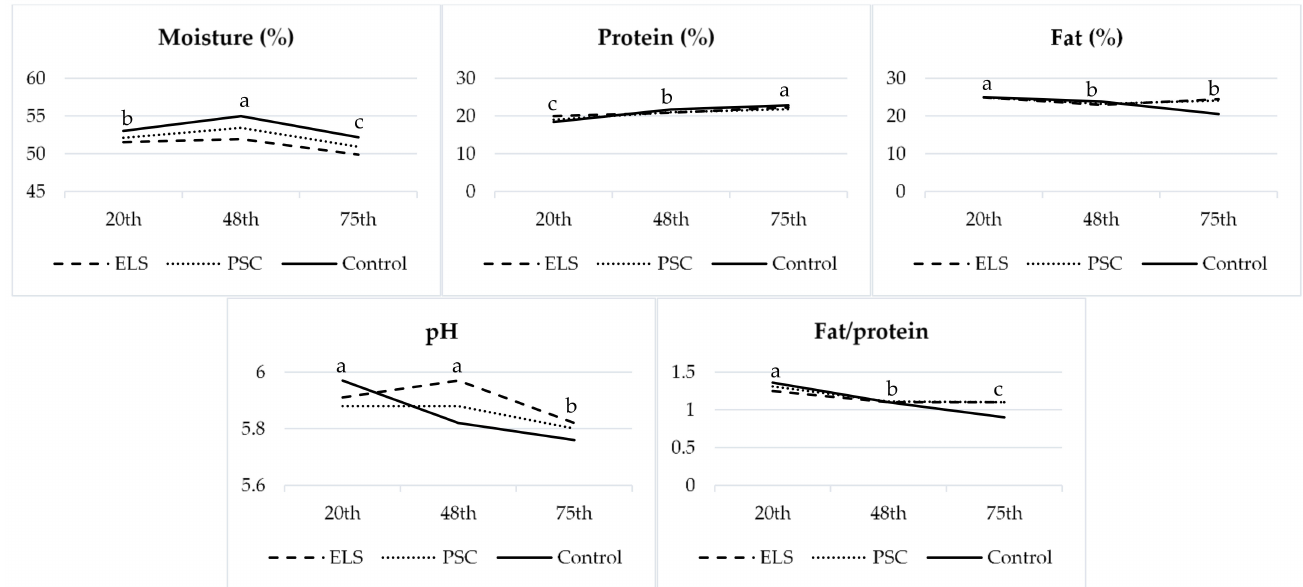
Figure 1. Gross chemical composition of semi-hard cheeses influenced by study period (32nd, 60th, and 87th day of lactation) of goats fed feed mixtures containing extruded linseed or pumpkin seed cake (ELS and PSC, respectively). a, b, c Values with different superscripts differ significantly at p ≤